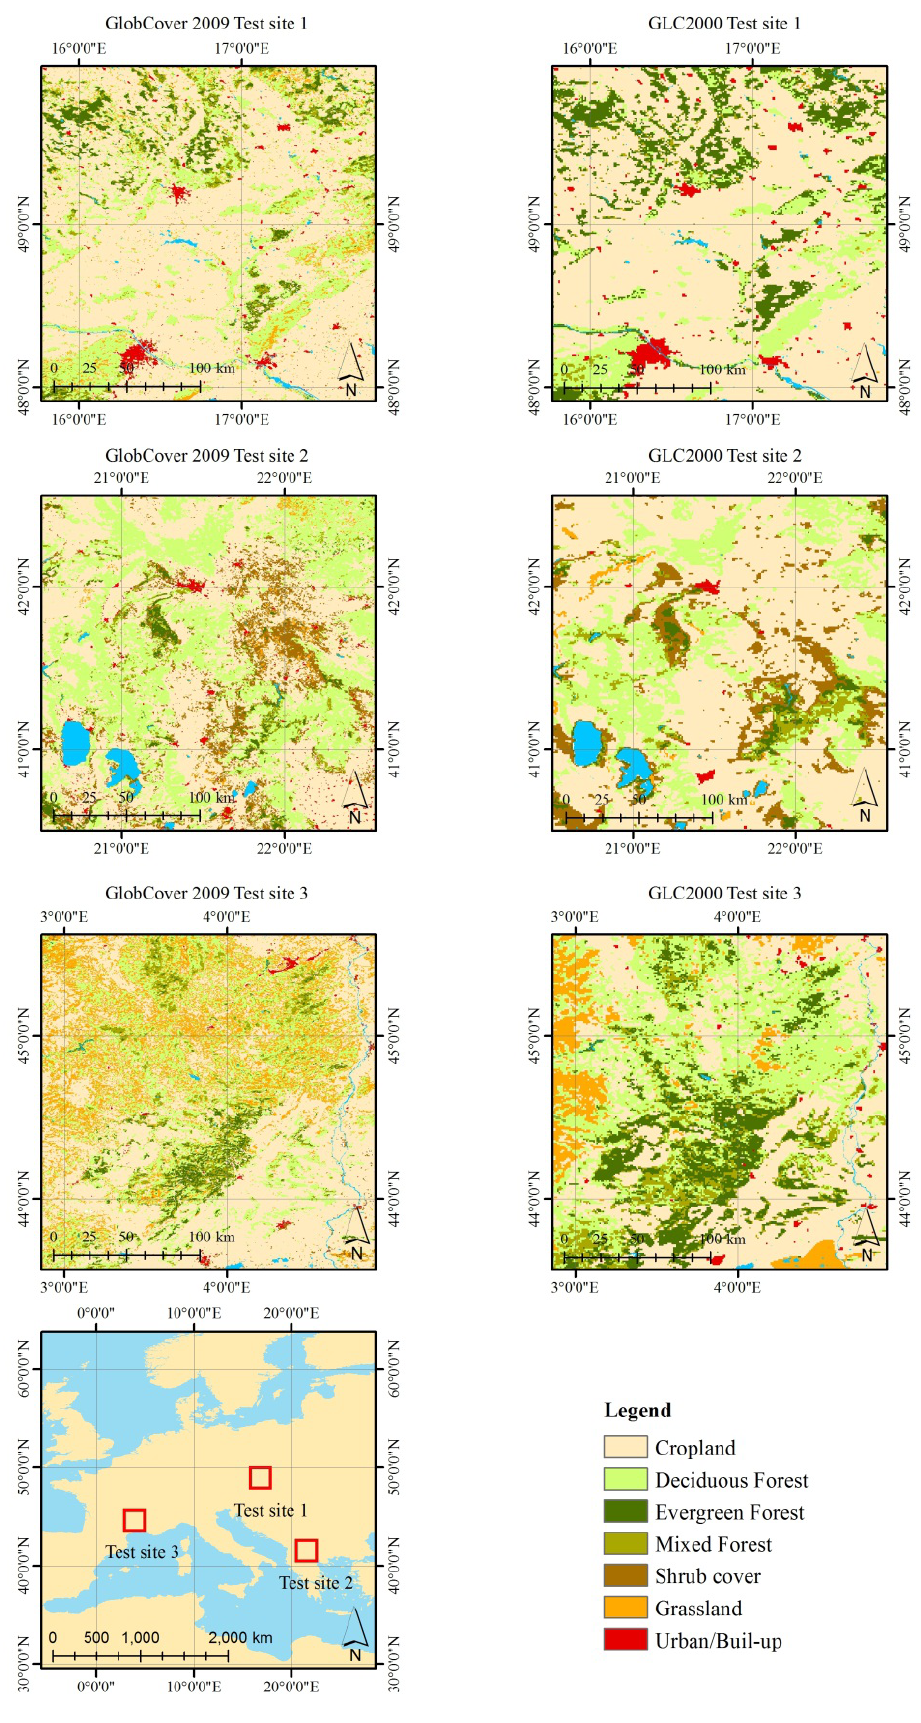
Figure 5. GLC2000 and GlobCover maps after legend aggregation for the three test